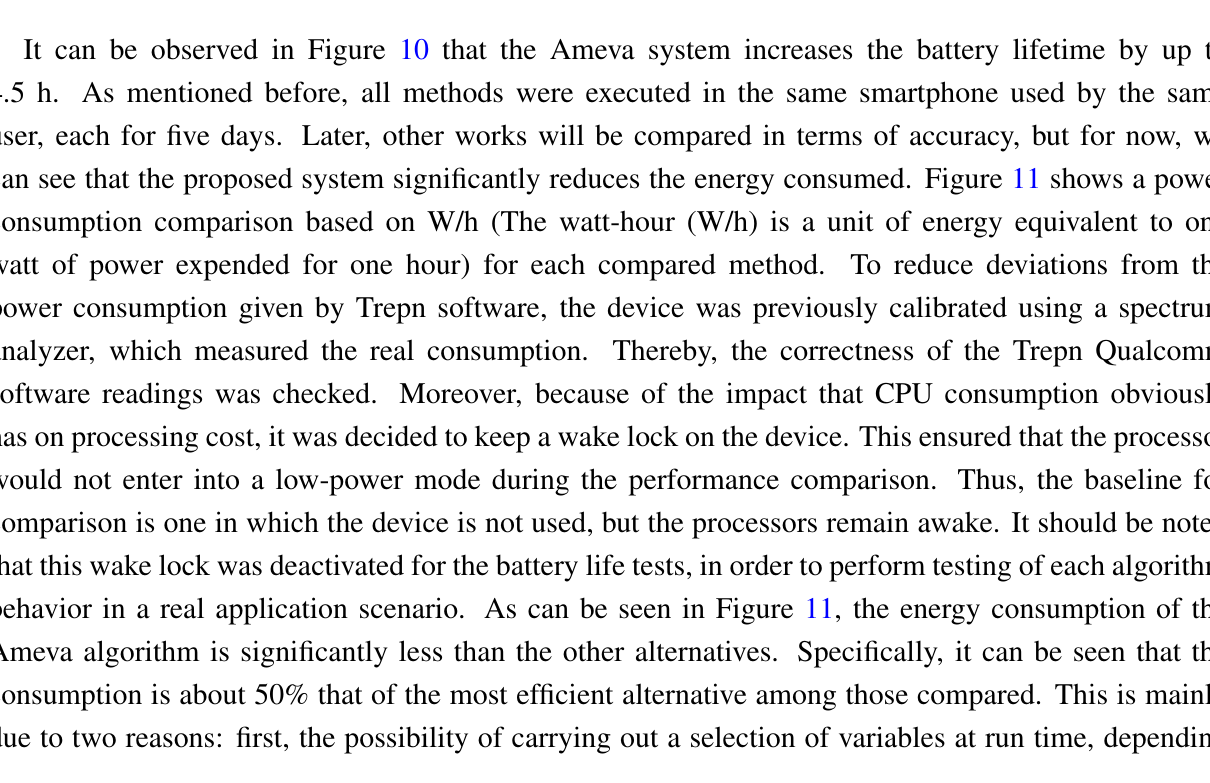
Figure 10. Battery lifetime analysis over other